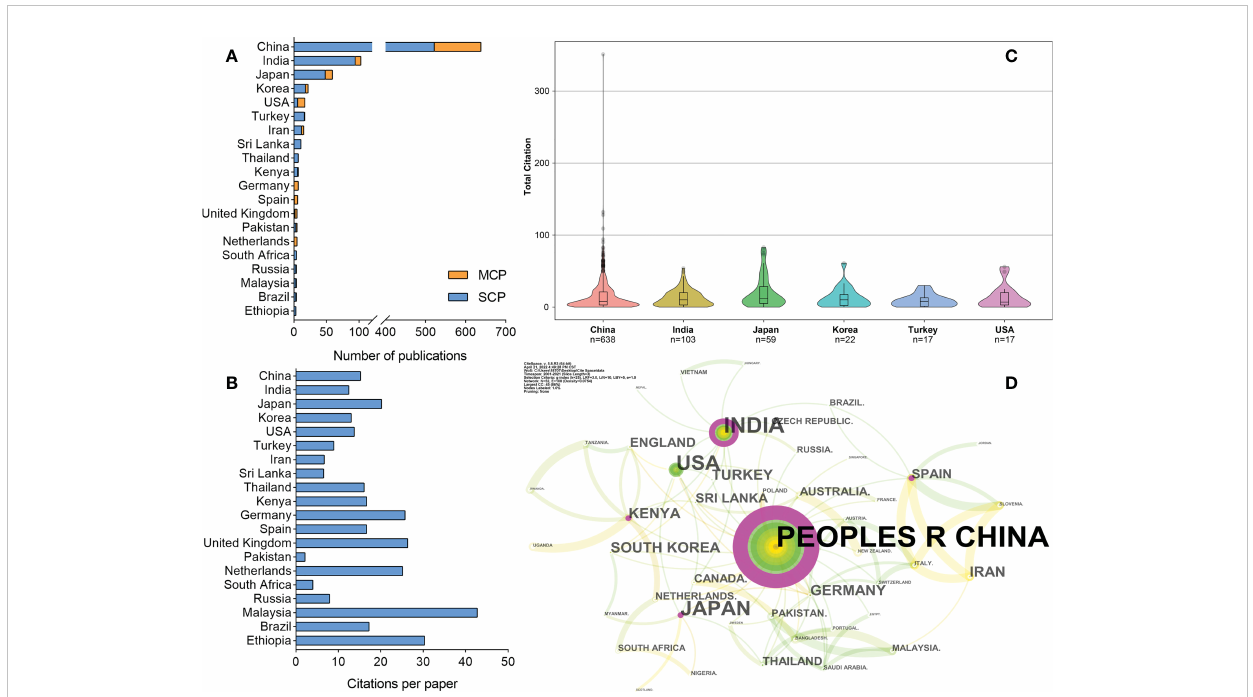
FIGURE 4 Countries ’ scienti fi c productions and collaboration relationship. (A) Scienti fi c production and international collaboration by countries. (B) Citations per publications for each country. (C) The citation distribution of all papers from the top six countries. (D) Collaboration network of countries generated with CiteSpace. The size of each node represents the citations of each country. Colors closer to the middle of the node represent older publication years, whereas exterior colors are more recent publication years. The purple circle means the node ’ s centrality ≥ 0.1, and the size of the circle is proportional to the centrality